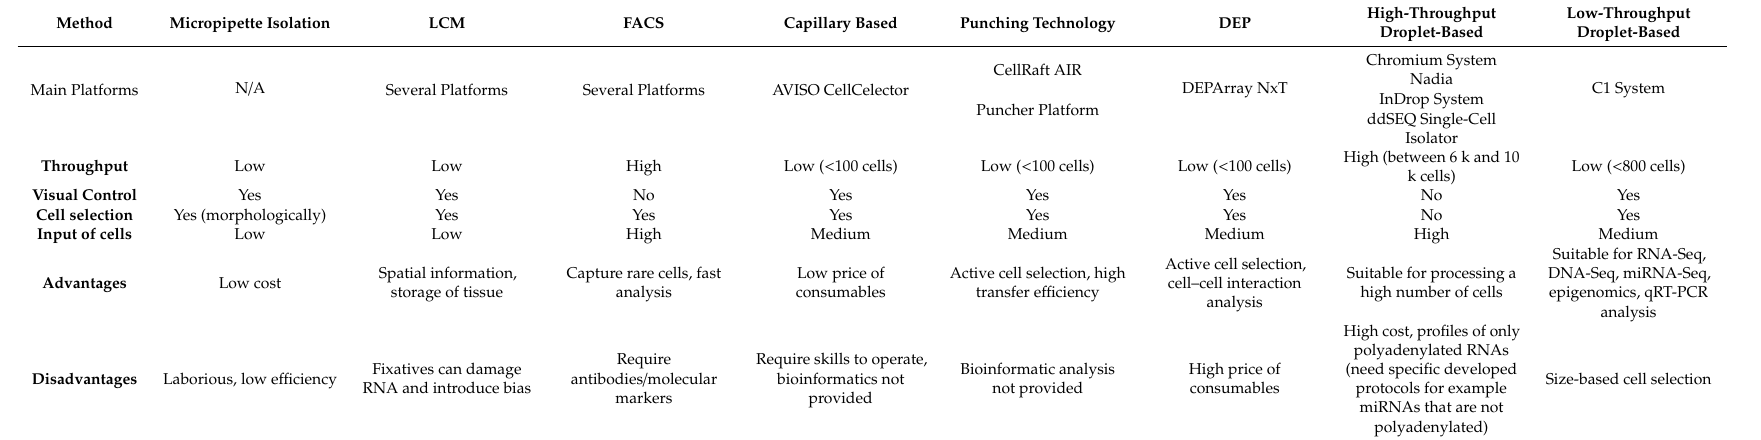
Table 1. Comparison of di ff erent techniques used to isolate single cells. LCM: laser capture microdissection; FACS Fluorescent Activated Cell Sorting; DEP: